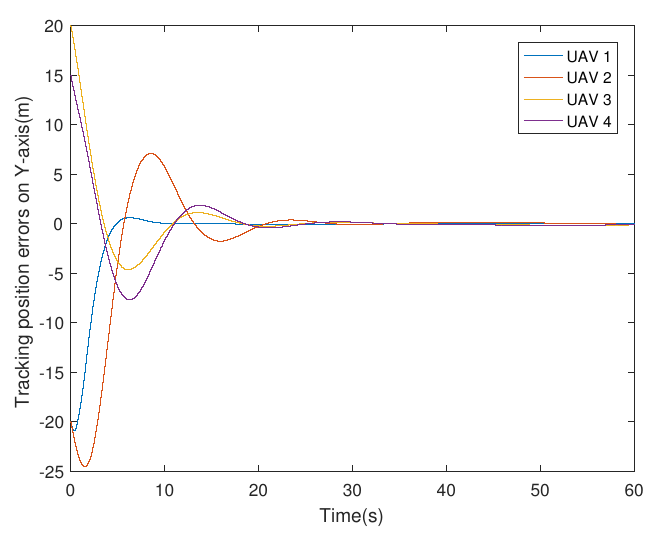
Figure 12. Responses of Ψ ix on X-axis.